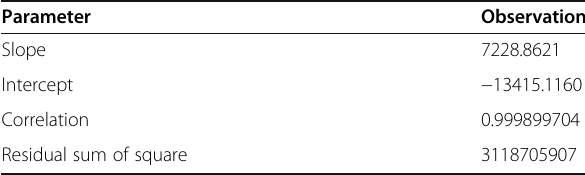
Table 2 Linearity plot results of gliclazide